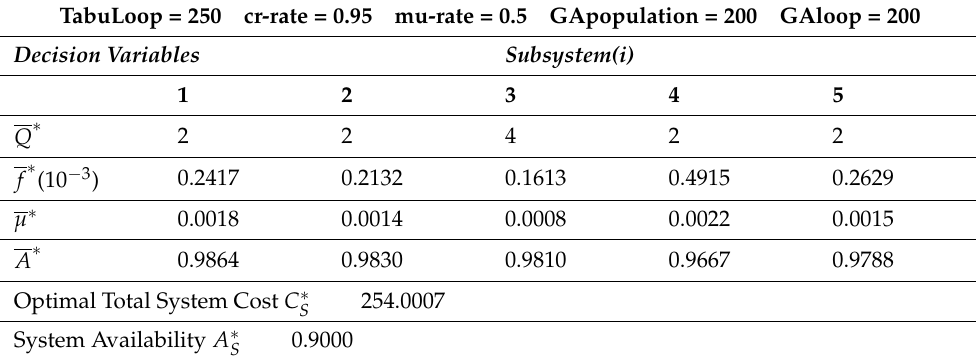
Table 28. Optimal Solutions obtained by TA–MGA for the n -stage q/2 -out-of- q system.